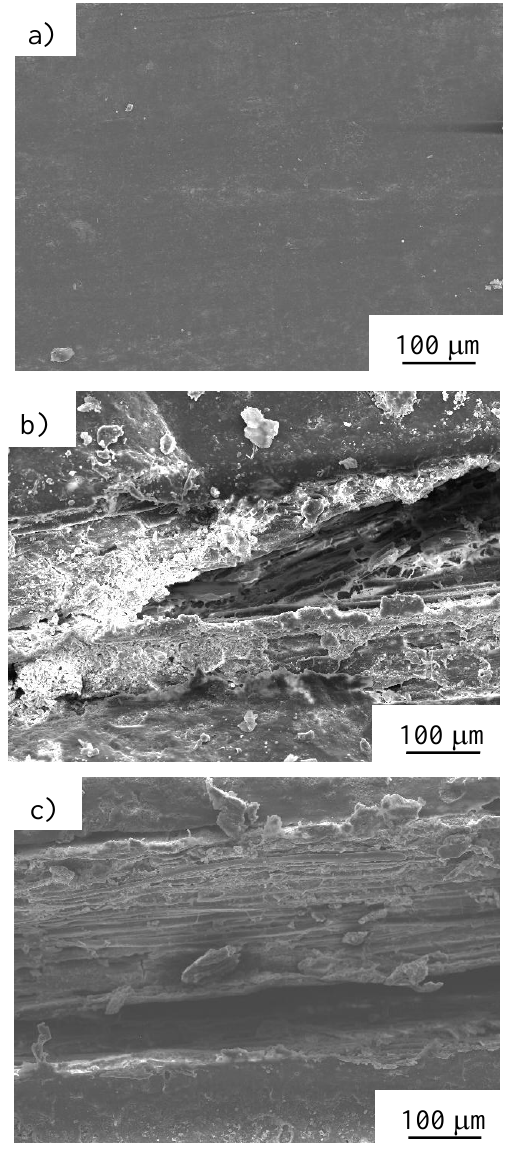
Figure 11. SEM photomicrographs of after biodegradable test of MHFRP after a) 30, b) 180 and c) 240 days burial (under Condition